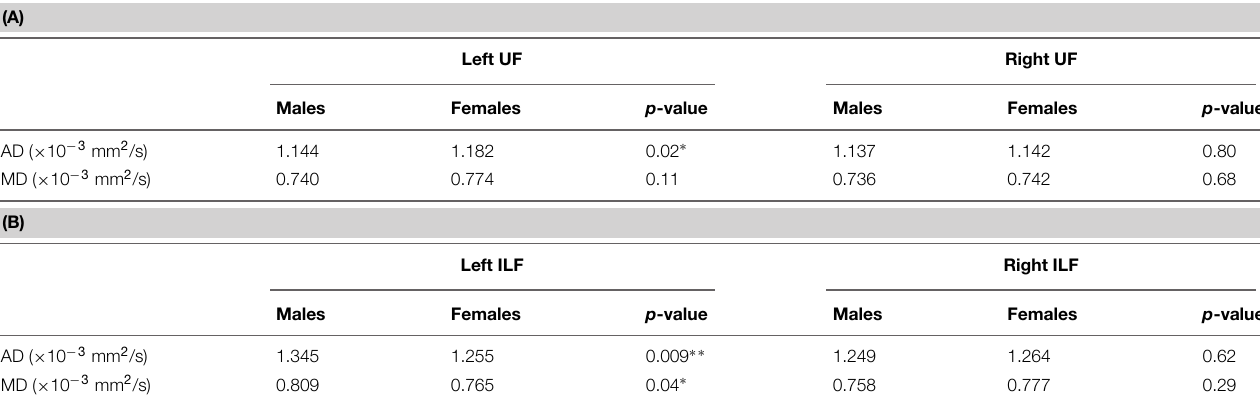
TABLE 2 | Relationship between gender and microstructural properties of the UF (A) and ILF (B).